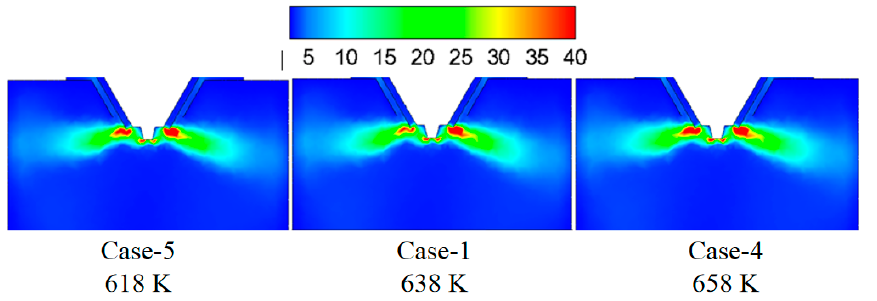
Figure 7. Turbulence kinetic energy under different flue gas temperatures (m 2 /s 2 ).